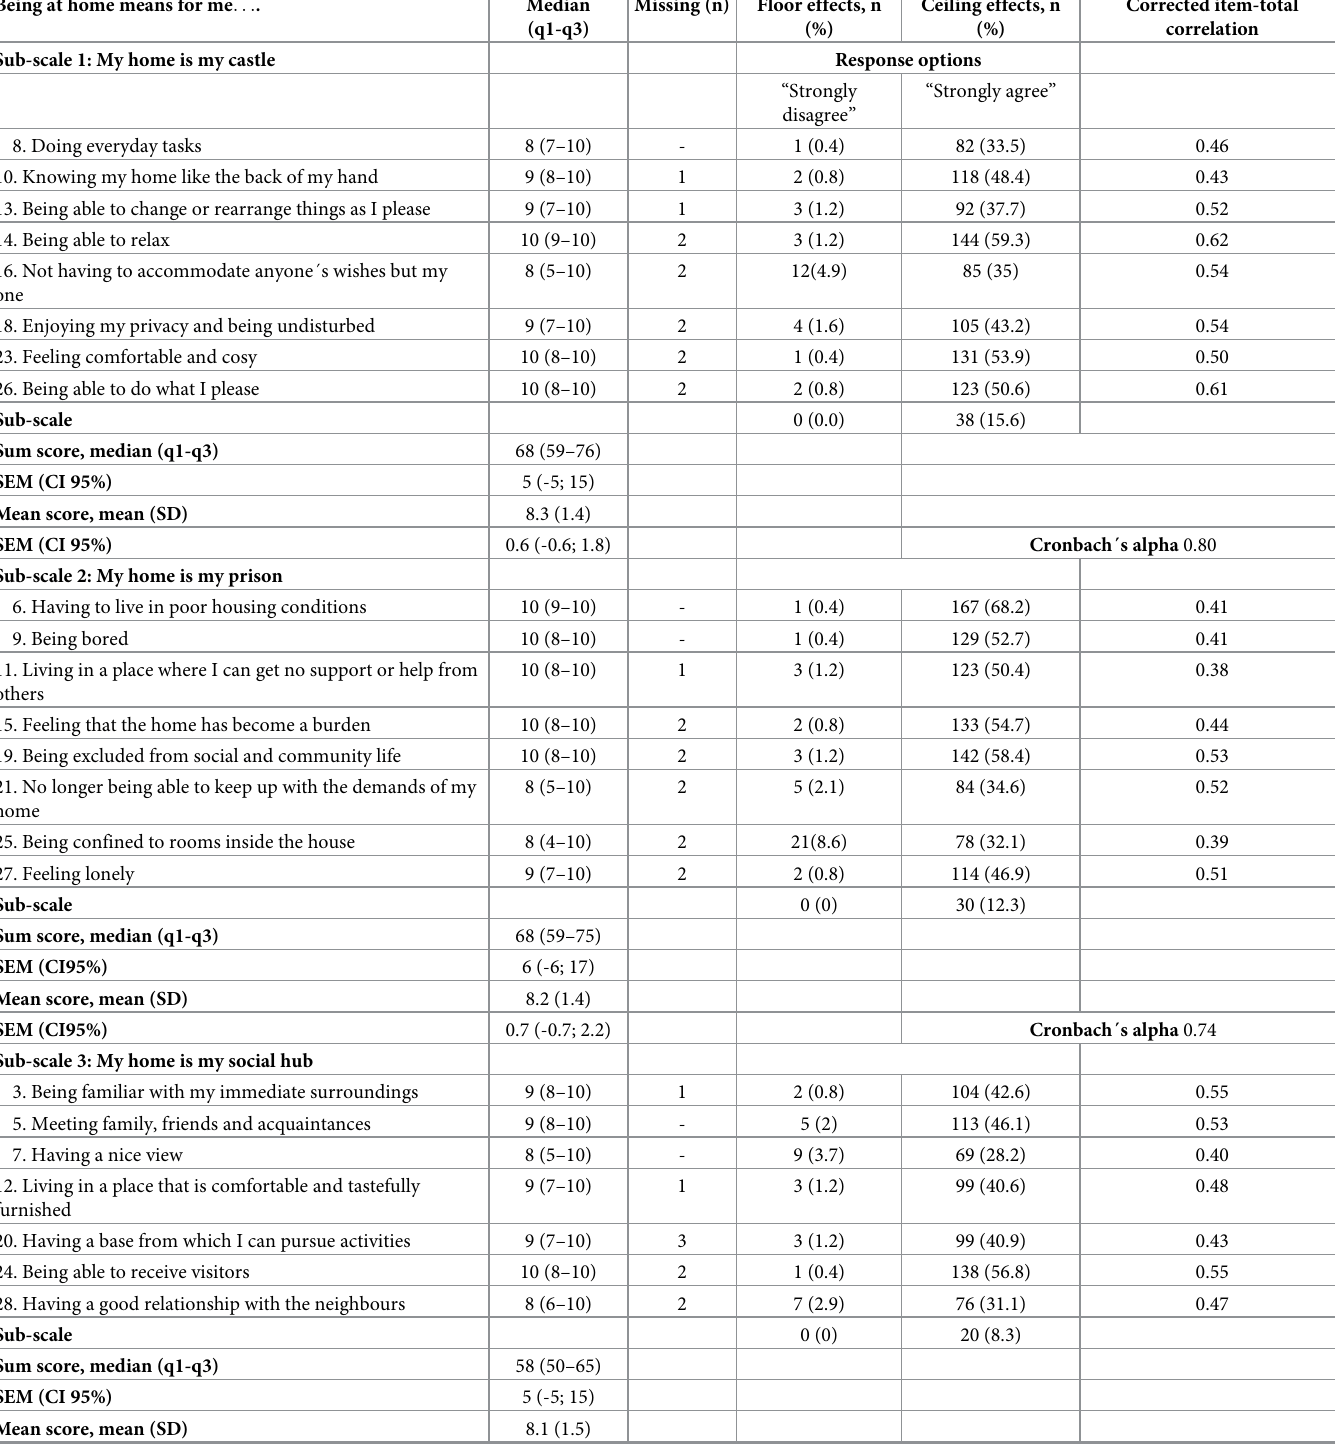
Table 3. Results of psychometric analysis for the 23-item MOH instrument after factor analysis, N = 245. Being at home means for me ...